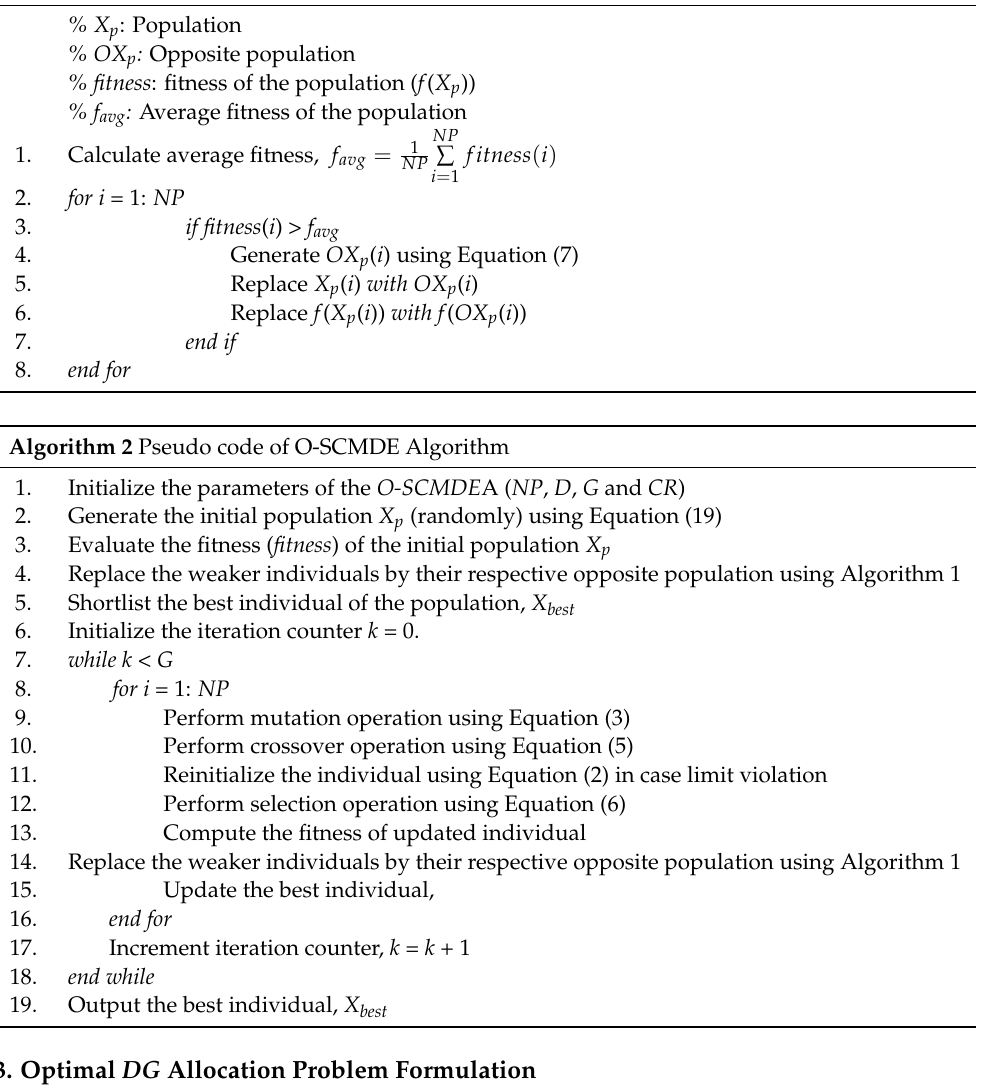
Algorithm 1 Pseudo-code for replacing weaker individuals with their opposite population